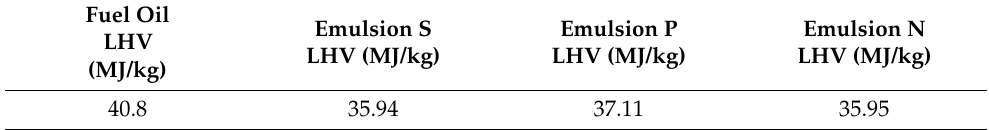
Table 11. Evolution of the low heat value of the various fuels in the addition 15% v / v of